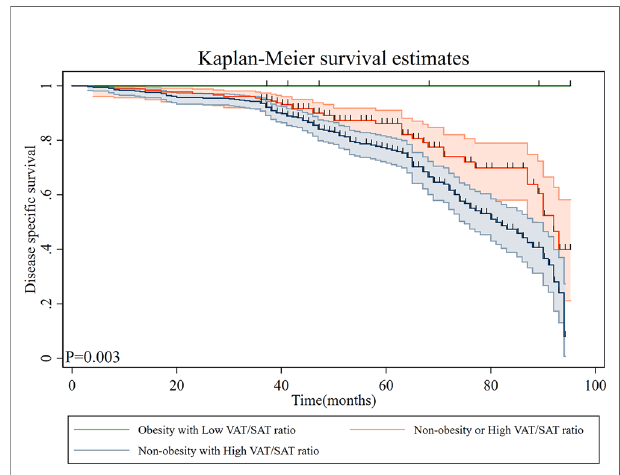
FIGURE 4 | Disease-speci fi c survival of patients with gastric cancer according to overweight/obesity and VAT/SAT ratio category. VAT, visceral adipose tissue; SAT, subcutaneous adipose tissue.